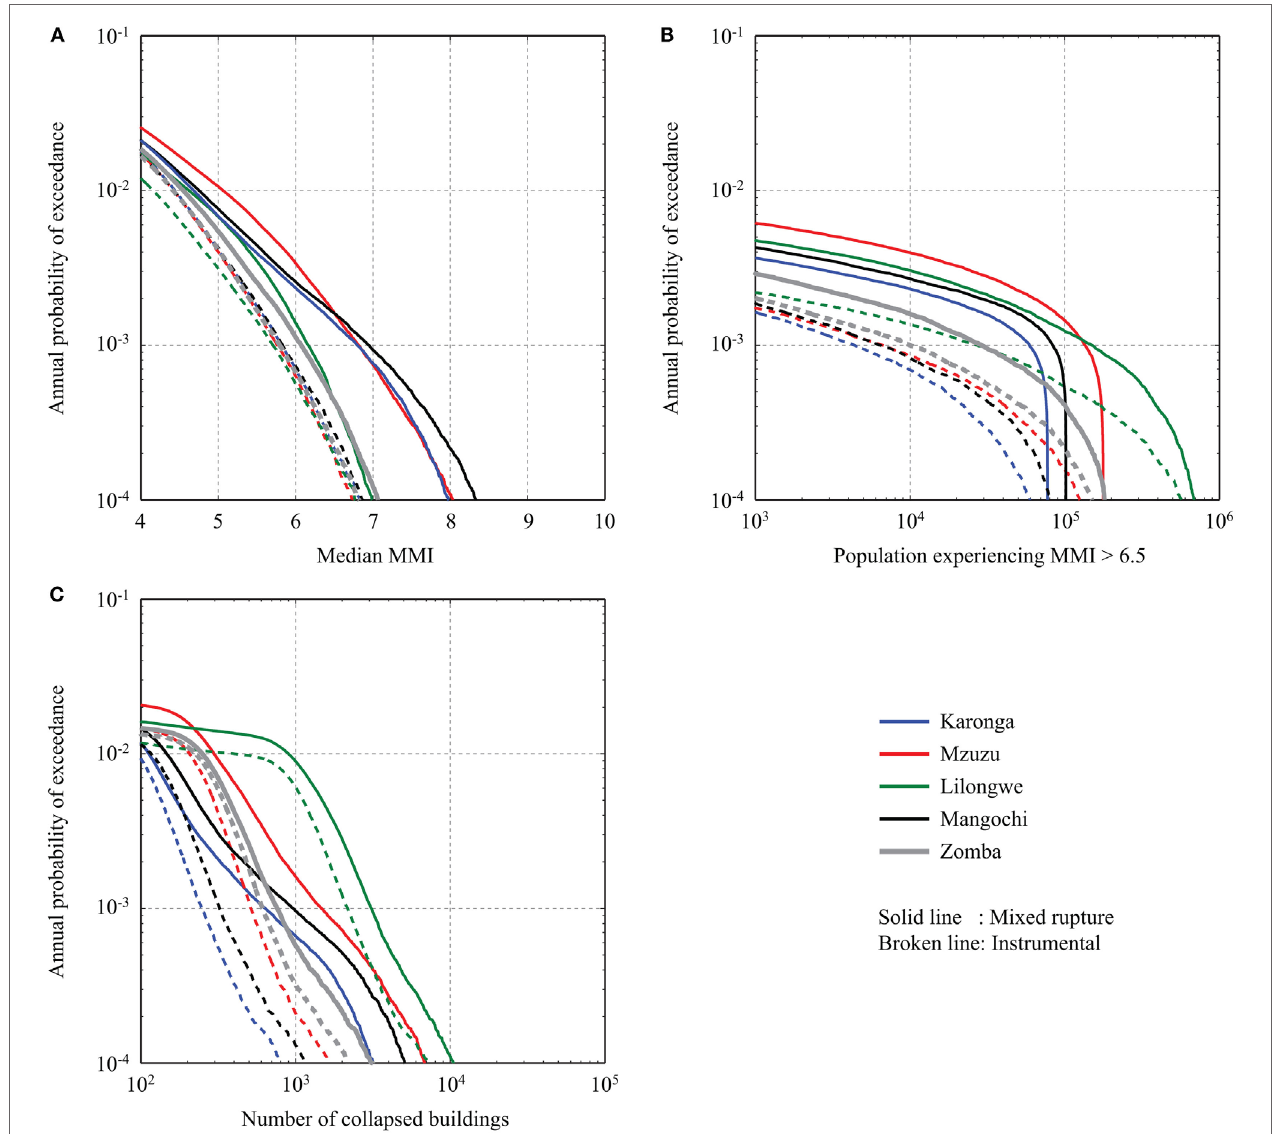
FigUre 15 | (a) Effects of instrumental catalog-based and mixed rupture models on MMI hazard curves for Karonga, Mzuzu, Lilongwe, Mangochi, and Zomba. (B) Effects of instrumental catalog-based and mixed rupture models on affected population curves (MMI > 6.5) for Karonga, Mzuzu, Lilongwe, Mangochi, and Zomba. (c) Effects of instrumental catalog-based and mixed rupture models on building-collapse curves for Karonga, Mzuzu, Lilongwe, Mangochi, and